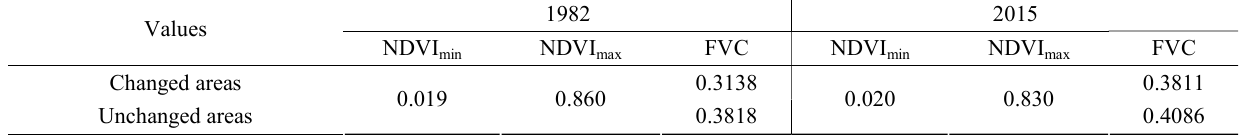
Tab.4 FVC of the Changed and Unchanged Areas in 1982 and 2015